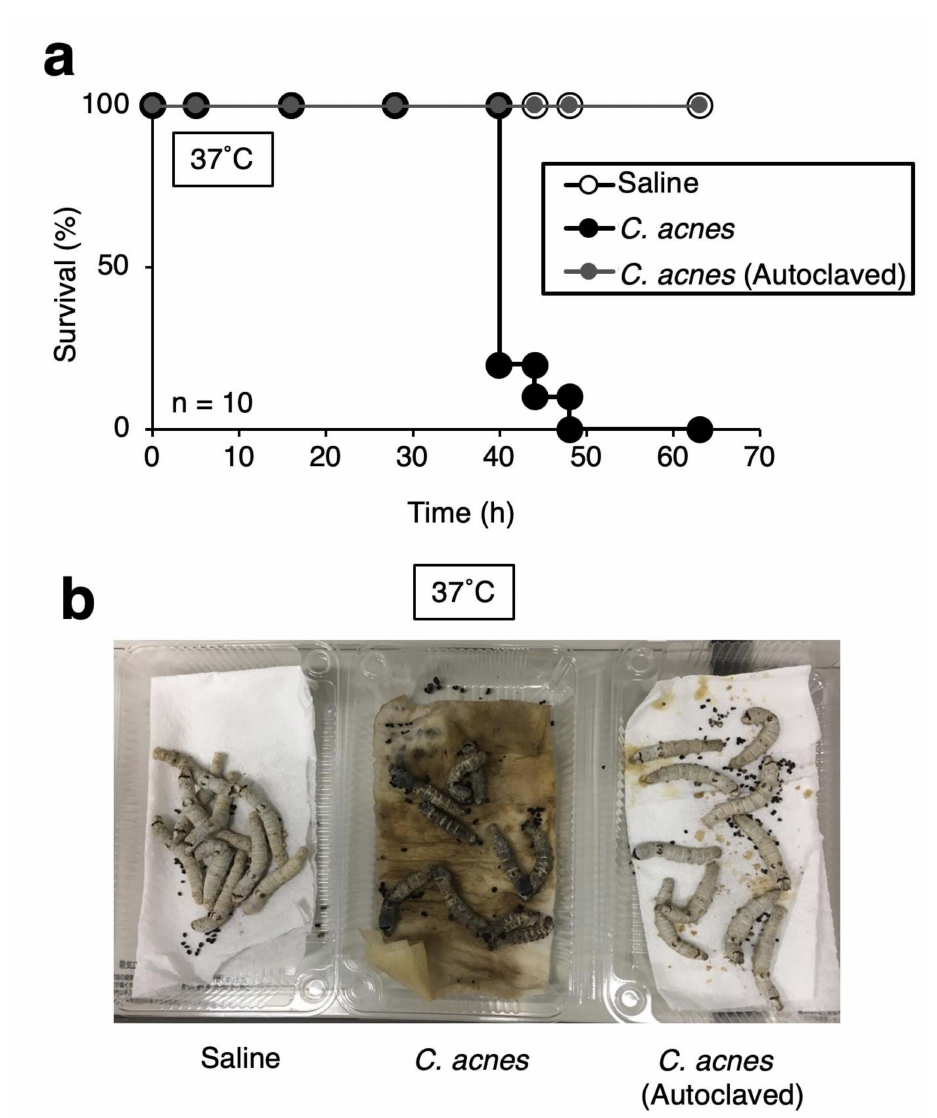
Figure 4. Effects of injecting autoclaved C. acnes cells in silkworms. ( a ) Silkworms were injected with saline (50 µ L), C. acnes cell suspension (7.8 × 10 8 cells/50 µ L), or autoclaved C. acnes cell suspension and incubated at 37 ◦ C. The number of surviving silkworms was measured for 63 h. n = 10/group. ( b ) Picture at 48 h after injection is